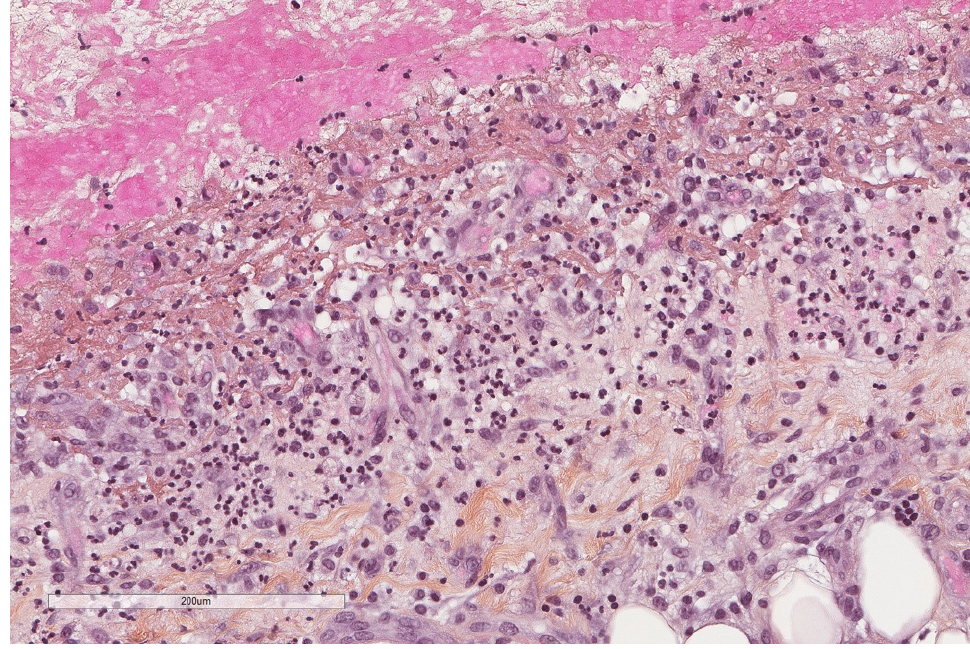
Figure 10. At this initial stage, neutrophils predominate. Hematoxylin, eosin, saffron staining ( × 400).